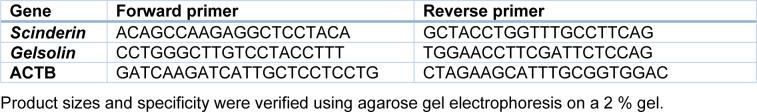
Specific primer sequences